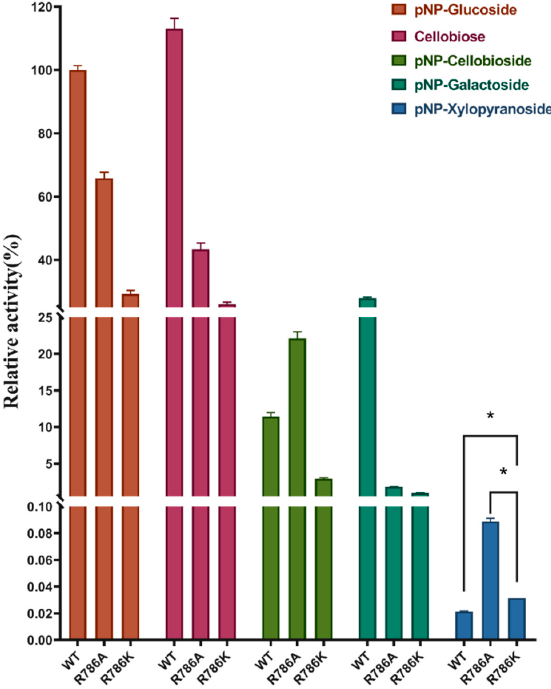
Figure 7. Relative activity on different substrates, p NP- β -D-glucopyranoside, cellobiose, p NP- β -cellobioside, p NP- β -D-galactopyranoside, and p NP- β -D-xylopyranoside. The assay contained 1 mM substrate in 50 mM sodium acetate buffer, pH 5.5, at 60 °C. Relative activity is based on p NP released from p NP- β -glycosides or glucose release from cellobiose. Data are expressed as means of three independent reactions ± SD. Stars represent one-way ANOVA significance at p < 0.05.